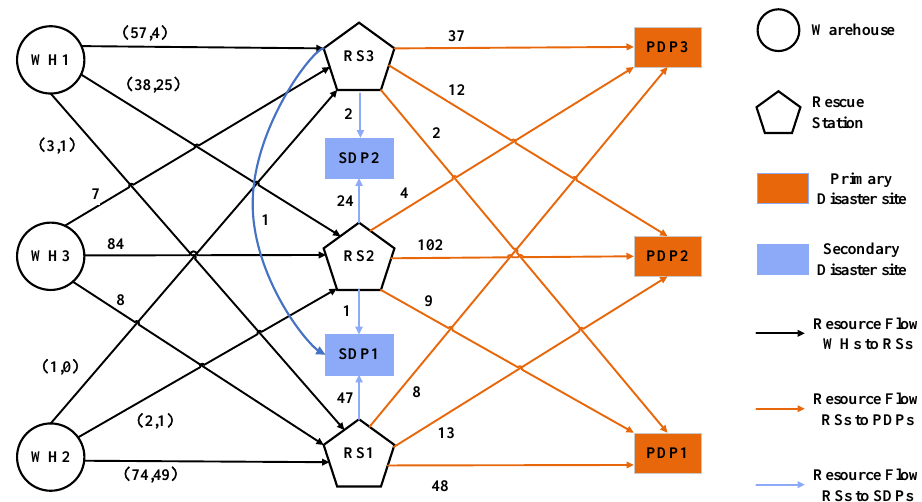
Figure 11. Optimized delivery flow network with additional resources in T =